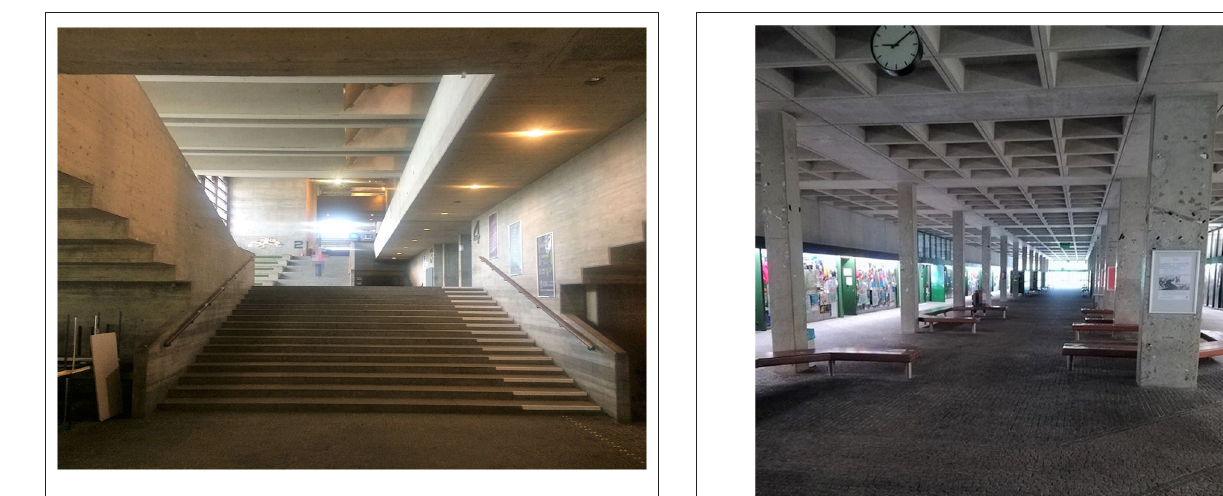
I study sports, and only I knew about this (sports) event (a fun competition in dodge ball). This event is free and you can try out everything. I thought it is so sad, on campus there are so many posters etc. about parties etc. but nothing about this sport event. You